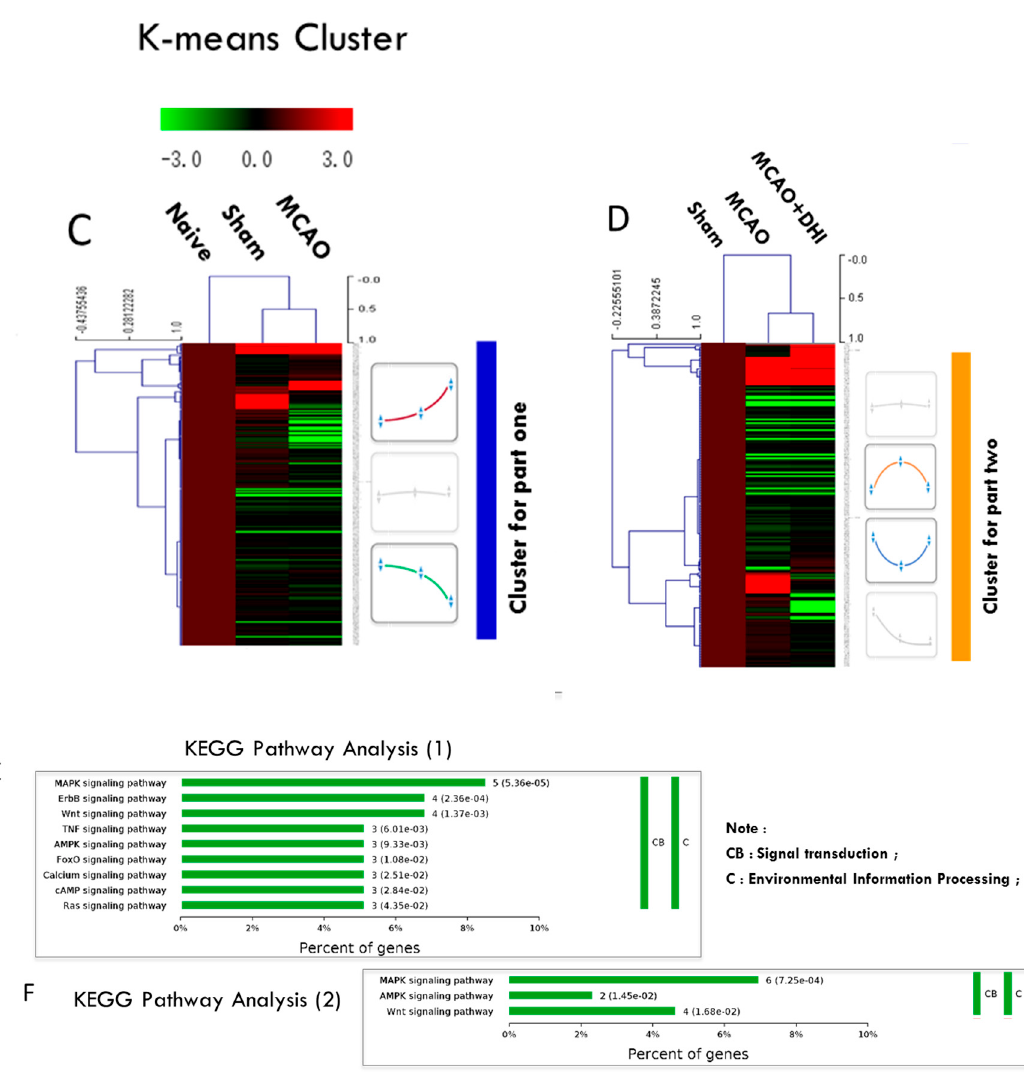
Figure 3. Gene Ontology (GO)/KEGG pathway analysis and K-means clustering analysis of hippocampus proteins with significantly altered expression. ( A ) GO annotation and enrichment of the hippocampus proteins with significantly altered expression in part one; ( B ) GO annotation and enrichment of the hippocampus proteins with significantly altered expression in part two; ( C ) clustering of significant altered hippocampus proteins of part one, and the two major clusters extracted by K-means clustering for the next analysis; ( D ) clustering of significantly altered hippocampus proteins of part two, and the two major clusters extracted by K-means clustering for the next analysis; ( E ) the enriched biological pathways in these two major clusters of significantly altered proteins in part one, as viewed by KEGG pathway analysis; ( F ) KEGG pathway analysis of only enriched pathways related to signal transduction and environment for these significantly altered proteins of part two.